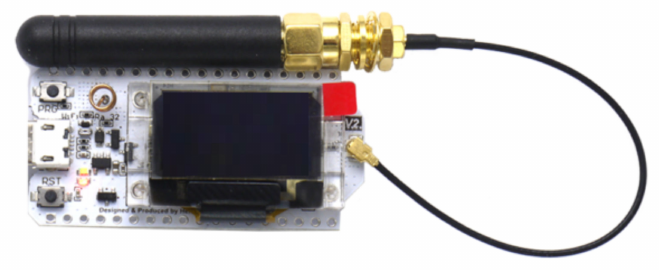
Figure 3. Node Heltec Wi-Fi LoRa